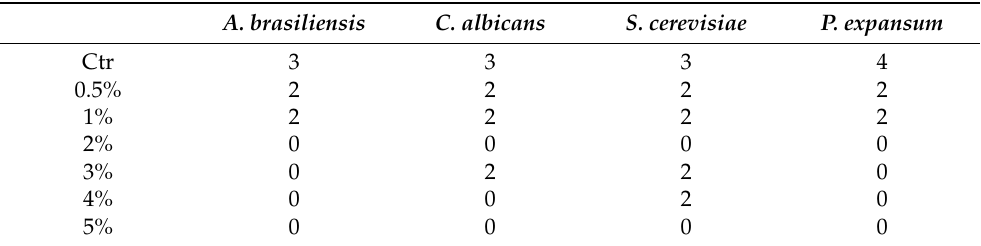
Table 2. Test results for the determination of fungistatic properties of polymer samples in accordance with ISO 846:2019.